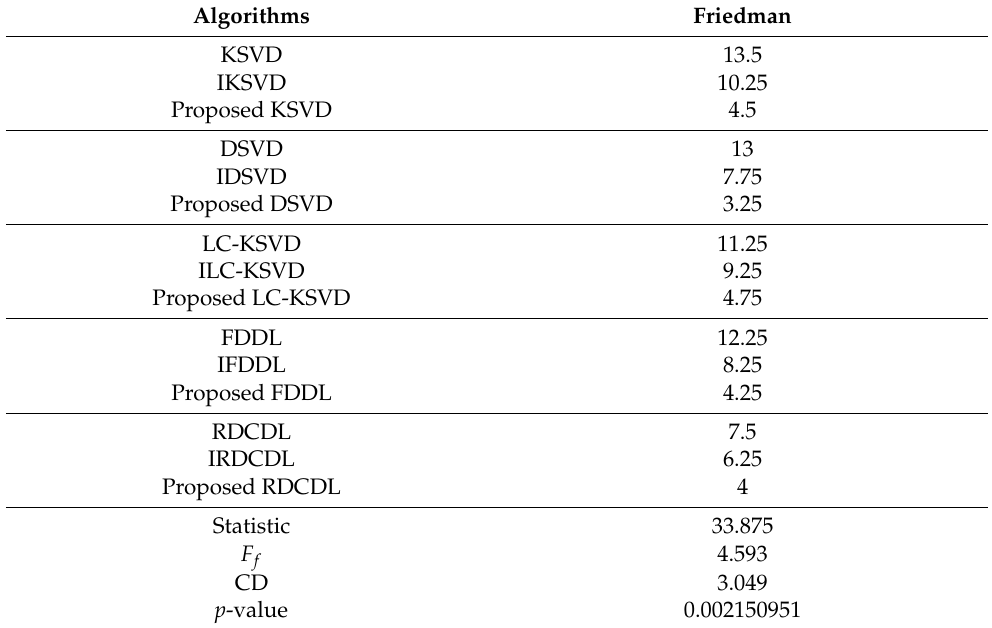
Table 5. Ranks achieved by the Friedman and Nemenyi tests in the study. Our DSVD and our RDCDL algorithms achieve the best rank in the procedures. The statistics computed and related p-values are also shown.